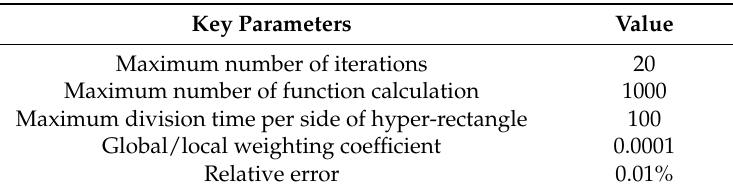
Figure 19. Optimization model for the HEV energy management key parameters. Table 11. Key parameters of DIRECT algorithm.